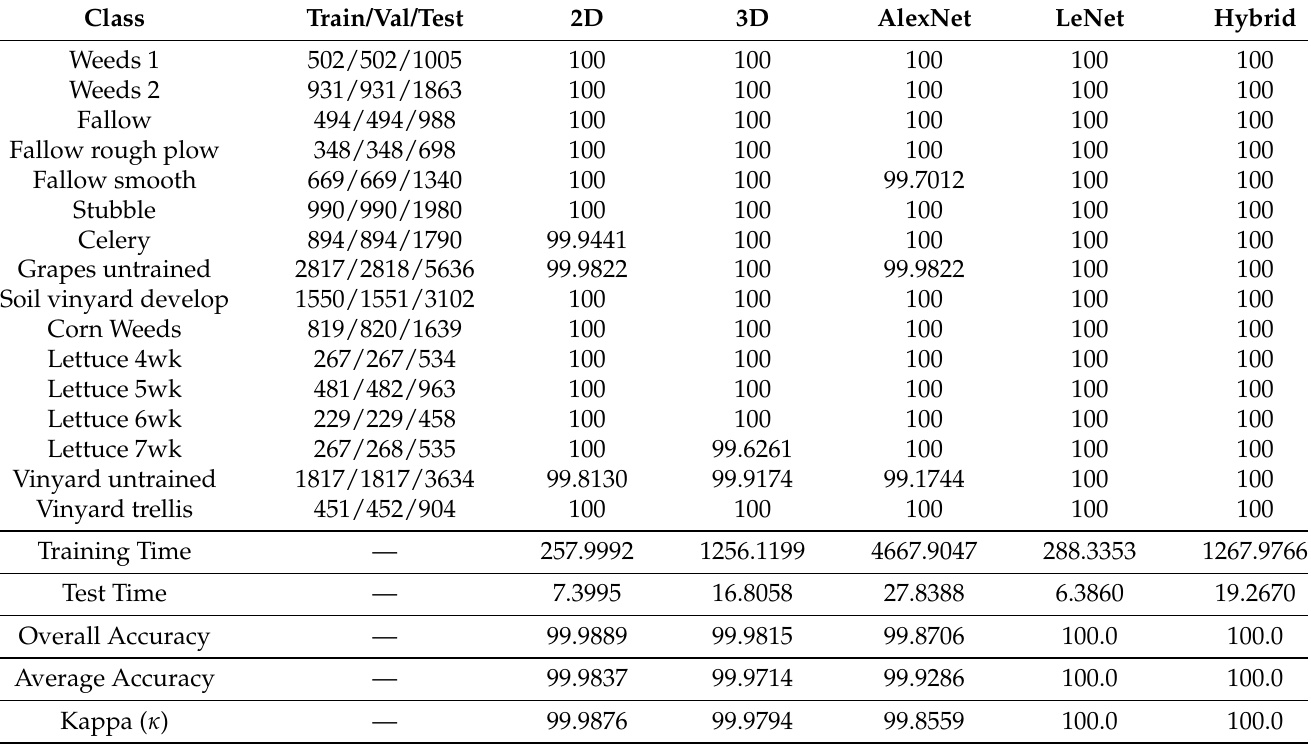
Table 3. Salinas: Performance analysis of different state-of-the-art models trained using regularization technique.